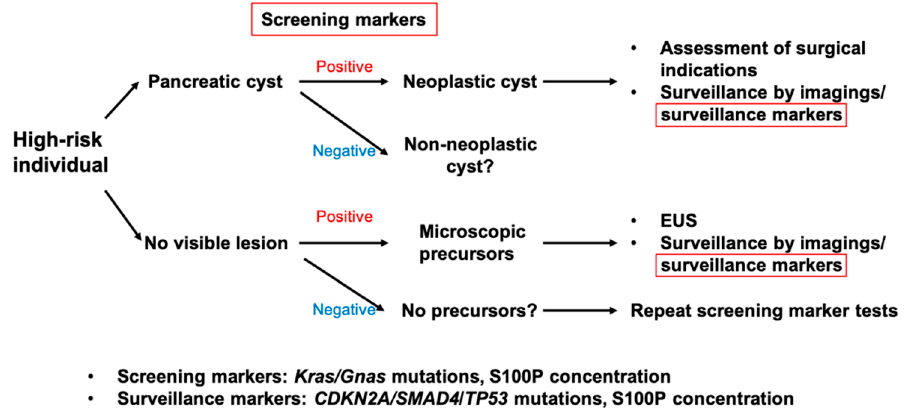
Figure 2. A proposed strategy for early detection of pancreatic cancer and the role of screening/surveillance biomarkers tested by fluid samples obtained by an endoscope. DF will be recommended as fluid sample.